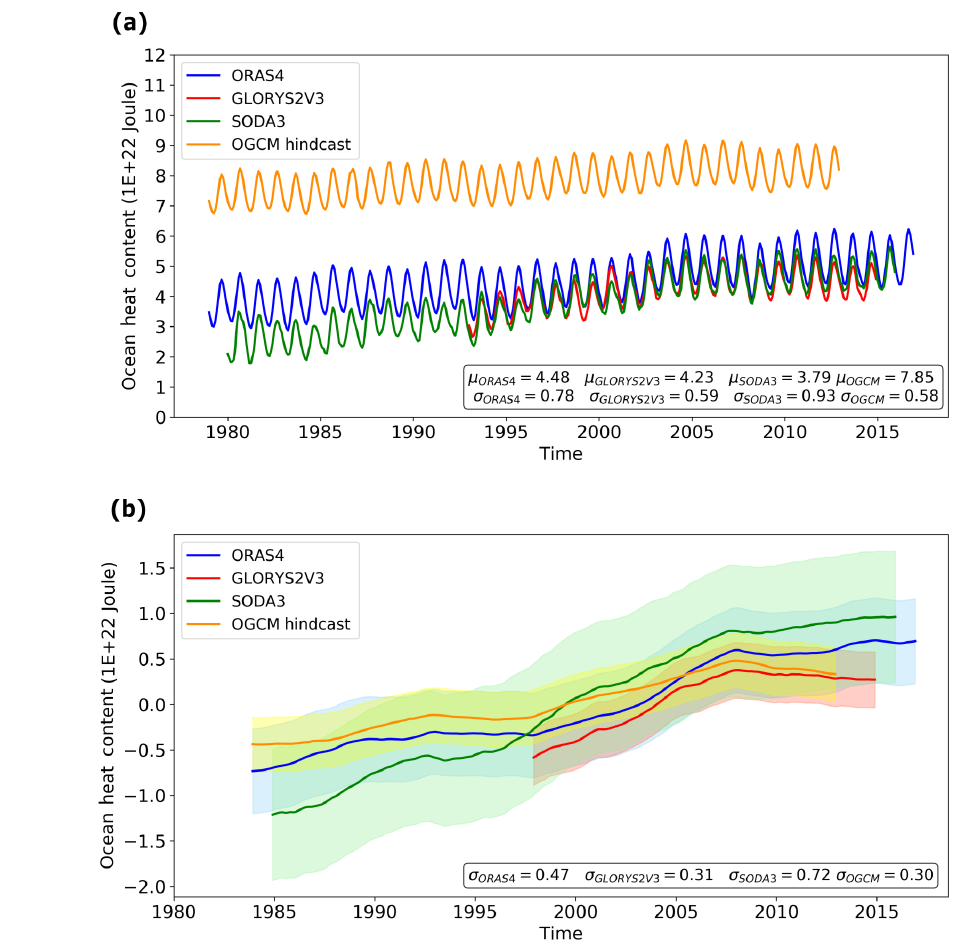
Figure 8. Time series of (a) OHC and (b) OHC anomalies with a low-pass filter at the polar cap. The OHC is integrated from surface to the bottom between 60 and 90 ◦ N. It is estimated from ORAS4 (blue), GLORYS2V3 (red), SODA3 (green) and the OGCM hindcast (yellow). The shades represent the confidence intervals with 1 standard deviation. σ is the standard deviation and µ is the mean of the entire time